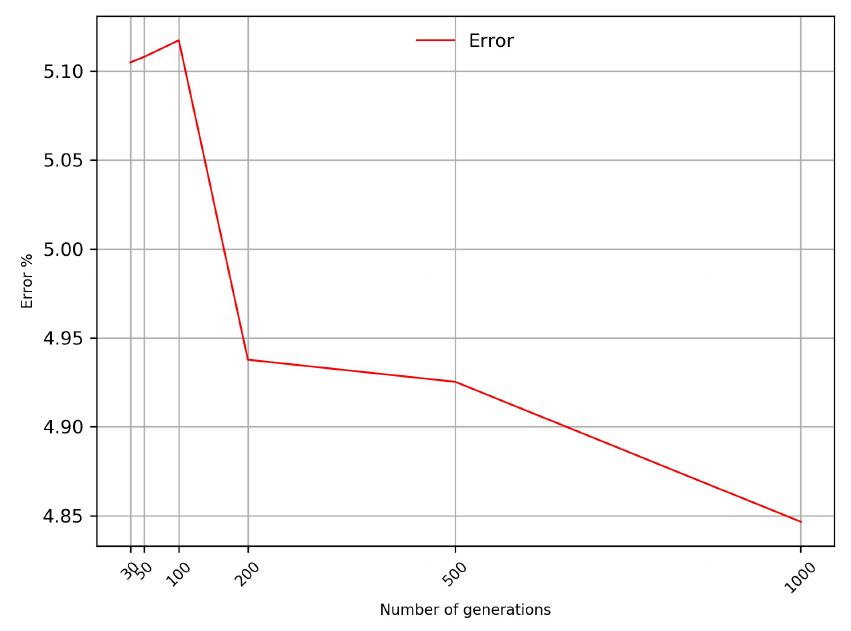
Figure 5. NRMSD % evolution according to the number of